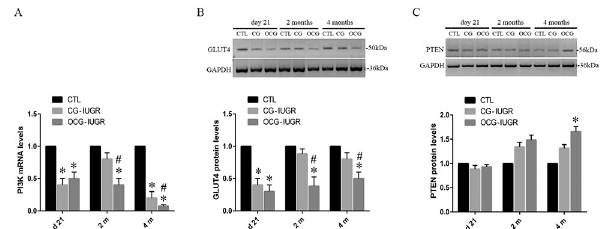
Fig 6. The expression levels of PI3K, PTEN and GLUT4 were analyzed in the IUGR offsprings with early catch-up growth. The mRNA levels of PI3K (A), as well as the protein levels of the GLUT4 (B) and PTEN (C) were assessed and compared among the controls and IUGR offsprings with catch-up (CG) or over catch-up growth (OCG). Data are shown as mean ± SD . n = 15 (CTL) , 6 (CG-IUGR) , and 4 (OCG-IUGR) . � p < 0 . 05 vs . CTL; # p < 0 . 05 vs . IUGR-CG